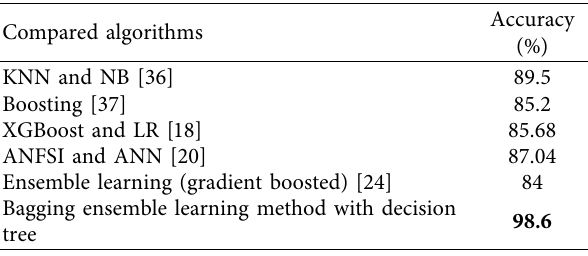
Table 10: Comparison of the results of proposed model with various other state-of-the-art algorithms [18, 20, 24, 36,